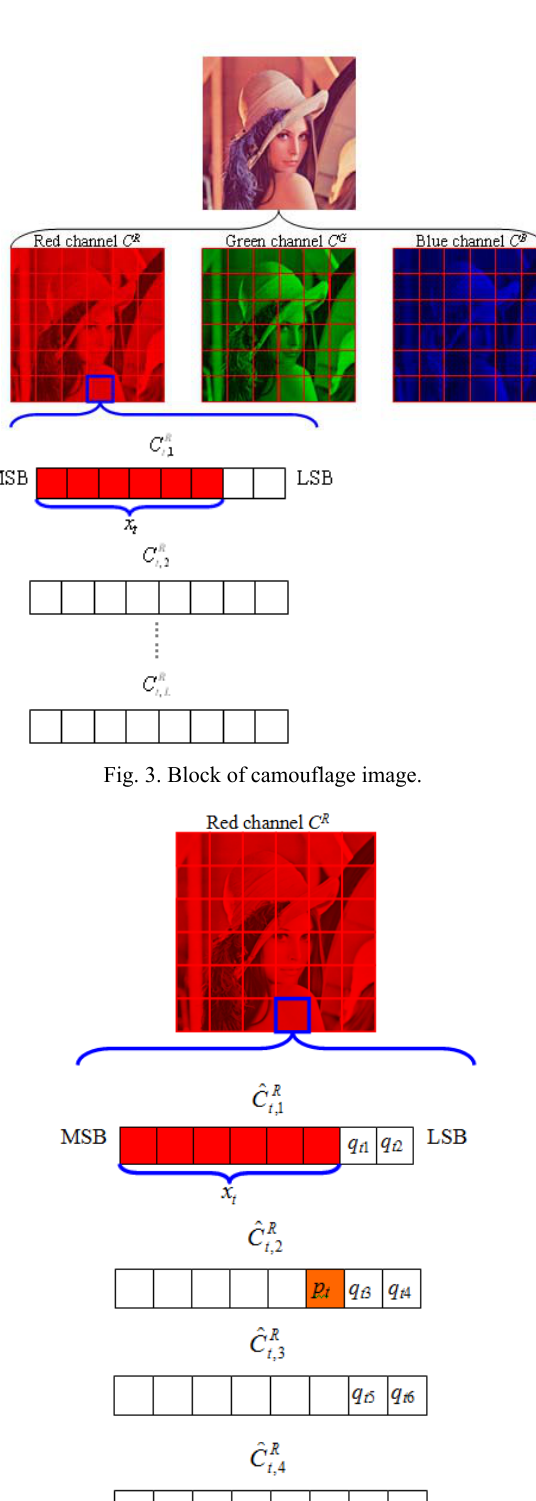
Fig. 4. Block of stego-image which assume L = 4.